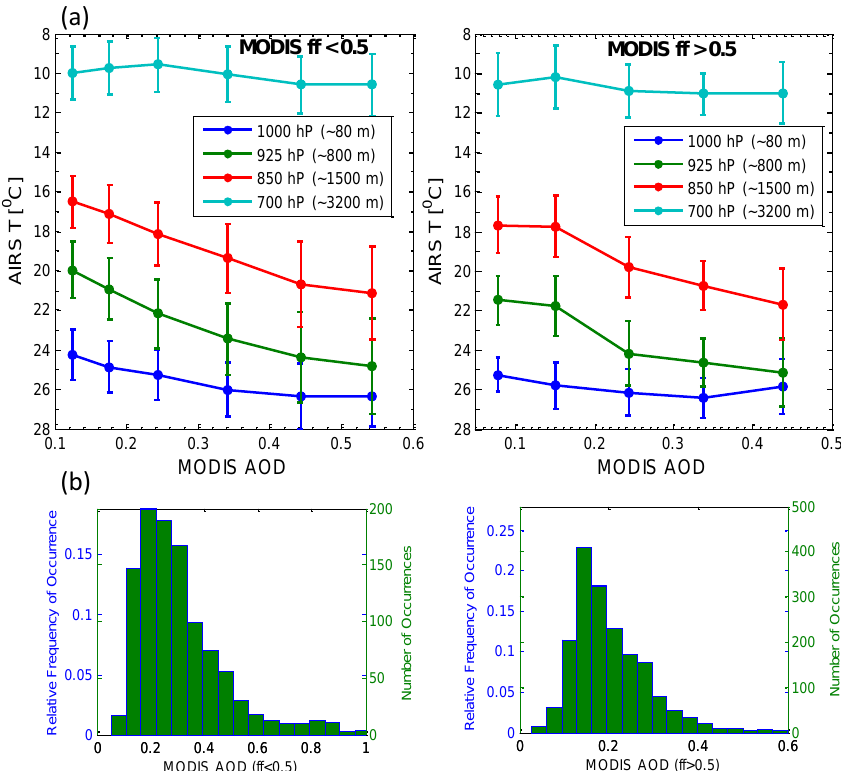
Figure 11. Same as (a) Fig. 10a and (b) Fig. 10b (upper panel) but separated in two cases of MODIS ff<0.5 (left panel) and MODIS ff>0.5 (right panel). The horizontal axis of Fig. 11a are different for two cases (ff<0.5 and ff>0.5) as AOD binning is done according to availability of data sets.